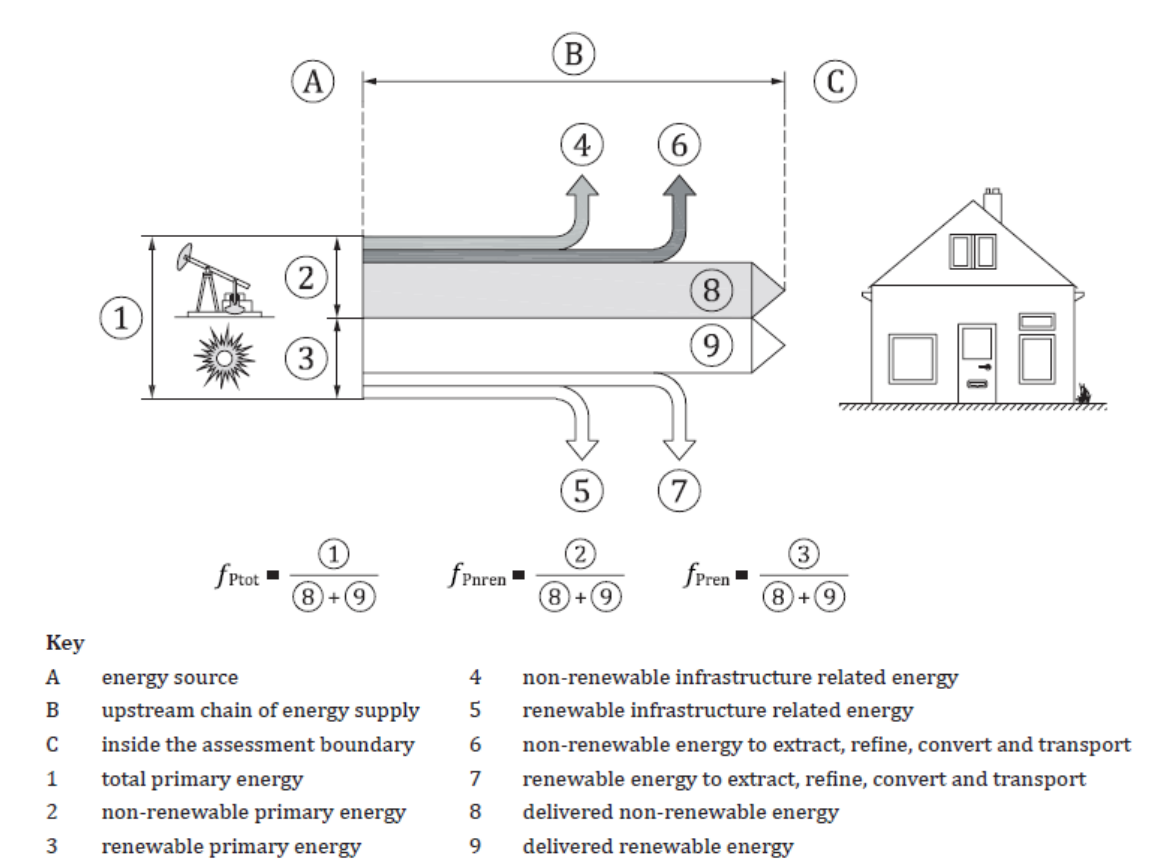
Figure 4. Primary energy factors approach according ISO-52000 [26].